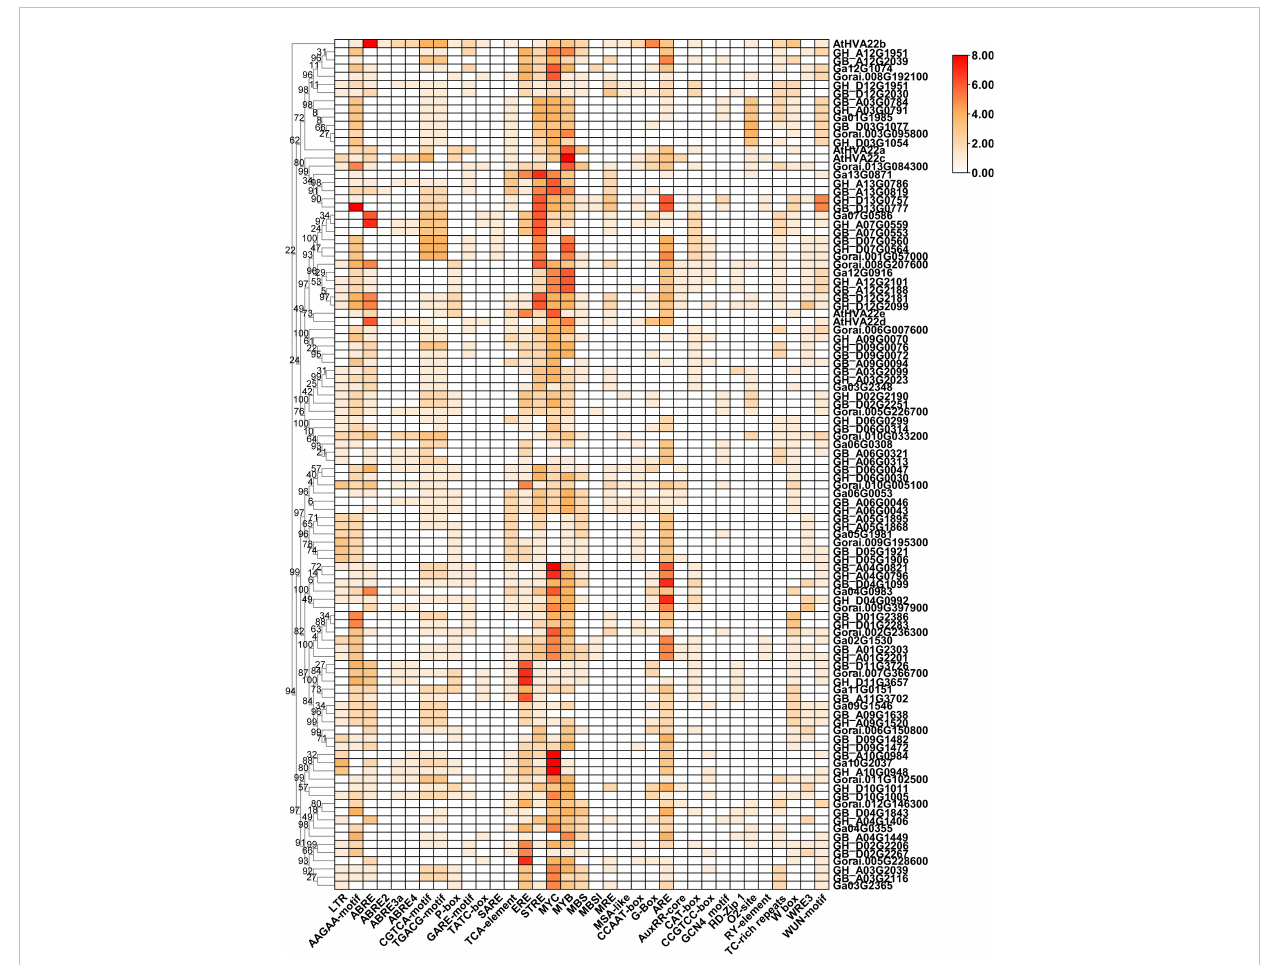
FIGURE 4 Predicted hormone response, stress response, and growth-related cis-elements in the promoter region of HVA22